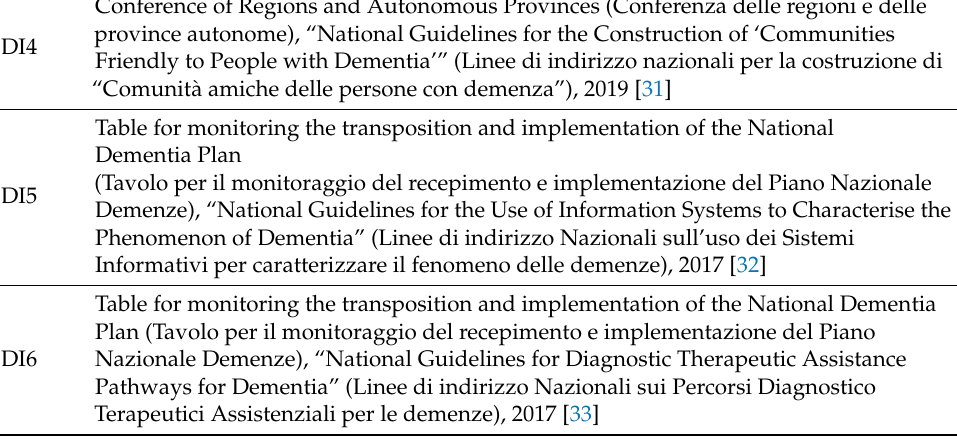
Table for monitoring the transposition and implementation of the National Dementia